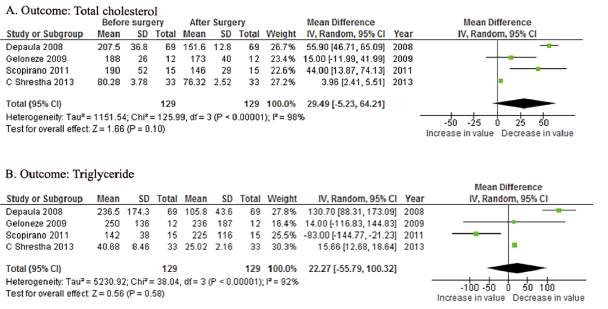
Fig 4. Forest plotsof the effects of metabolic surgery on: (A) total cholesterol and (B) triglyceride. CI = confidence interval; IV = inverse variance; SD = standard deviation.